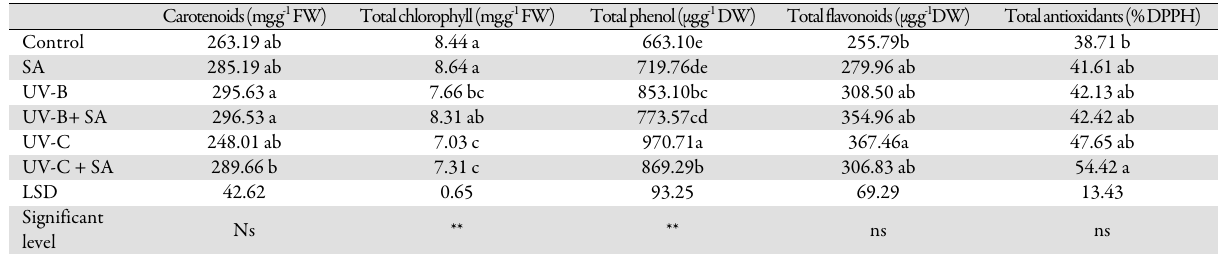
Table 2. Effect of treatments on physiological properties in the leaf extract of S. hortensis L.